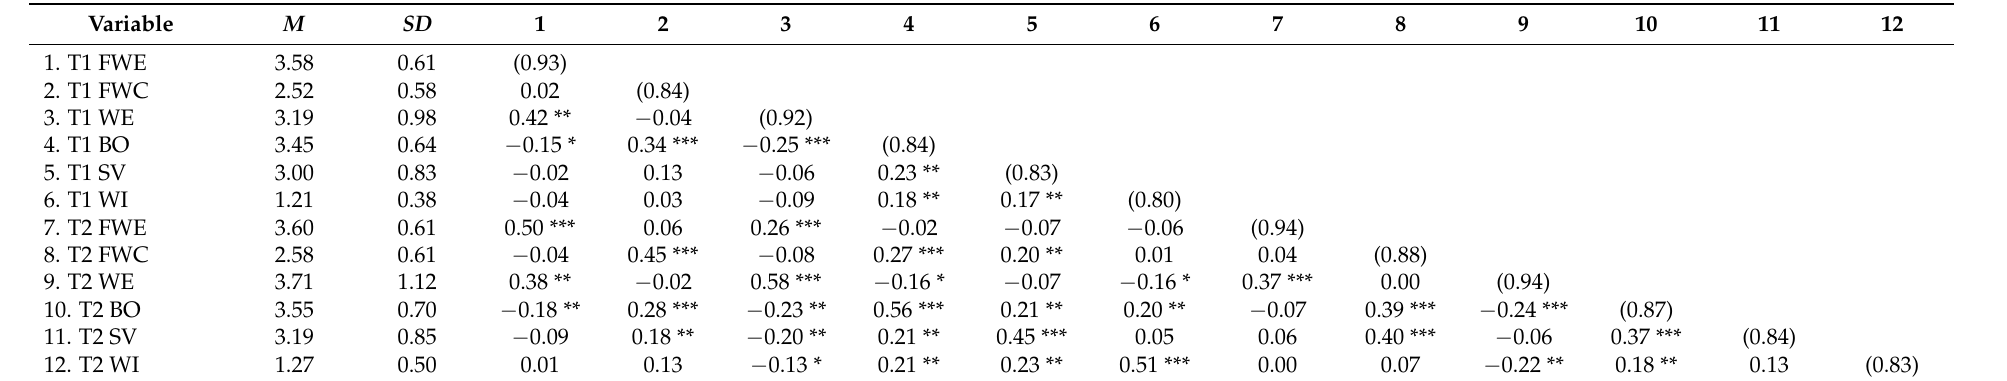
Table 2. Descriptive Statistics for the Major